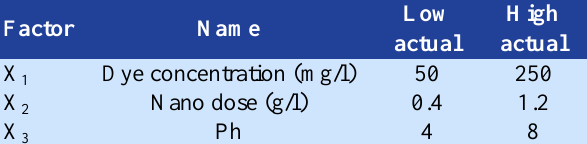
Table 1. Experimental design of